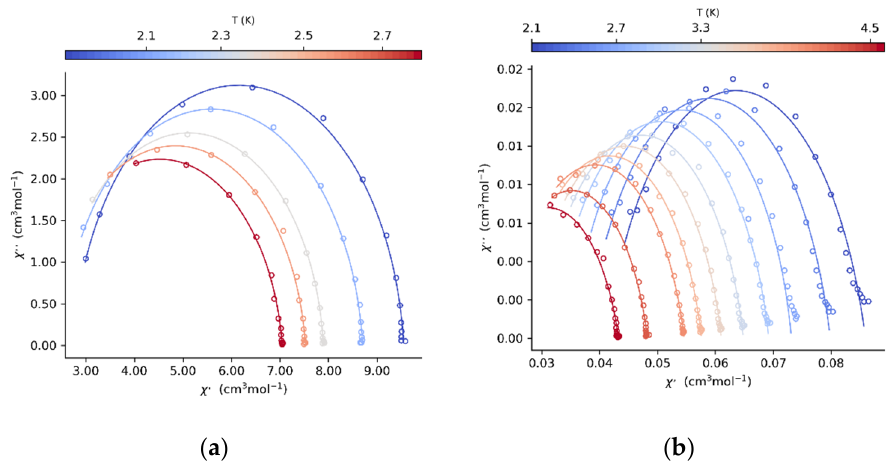
Figure 4. Cole-Cole plots for Dy 2 under 1000 Oe ( a ) and Dy 4 under 500 Oe ( b ) at the indicated temperature range. The solid lines represent the best